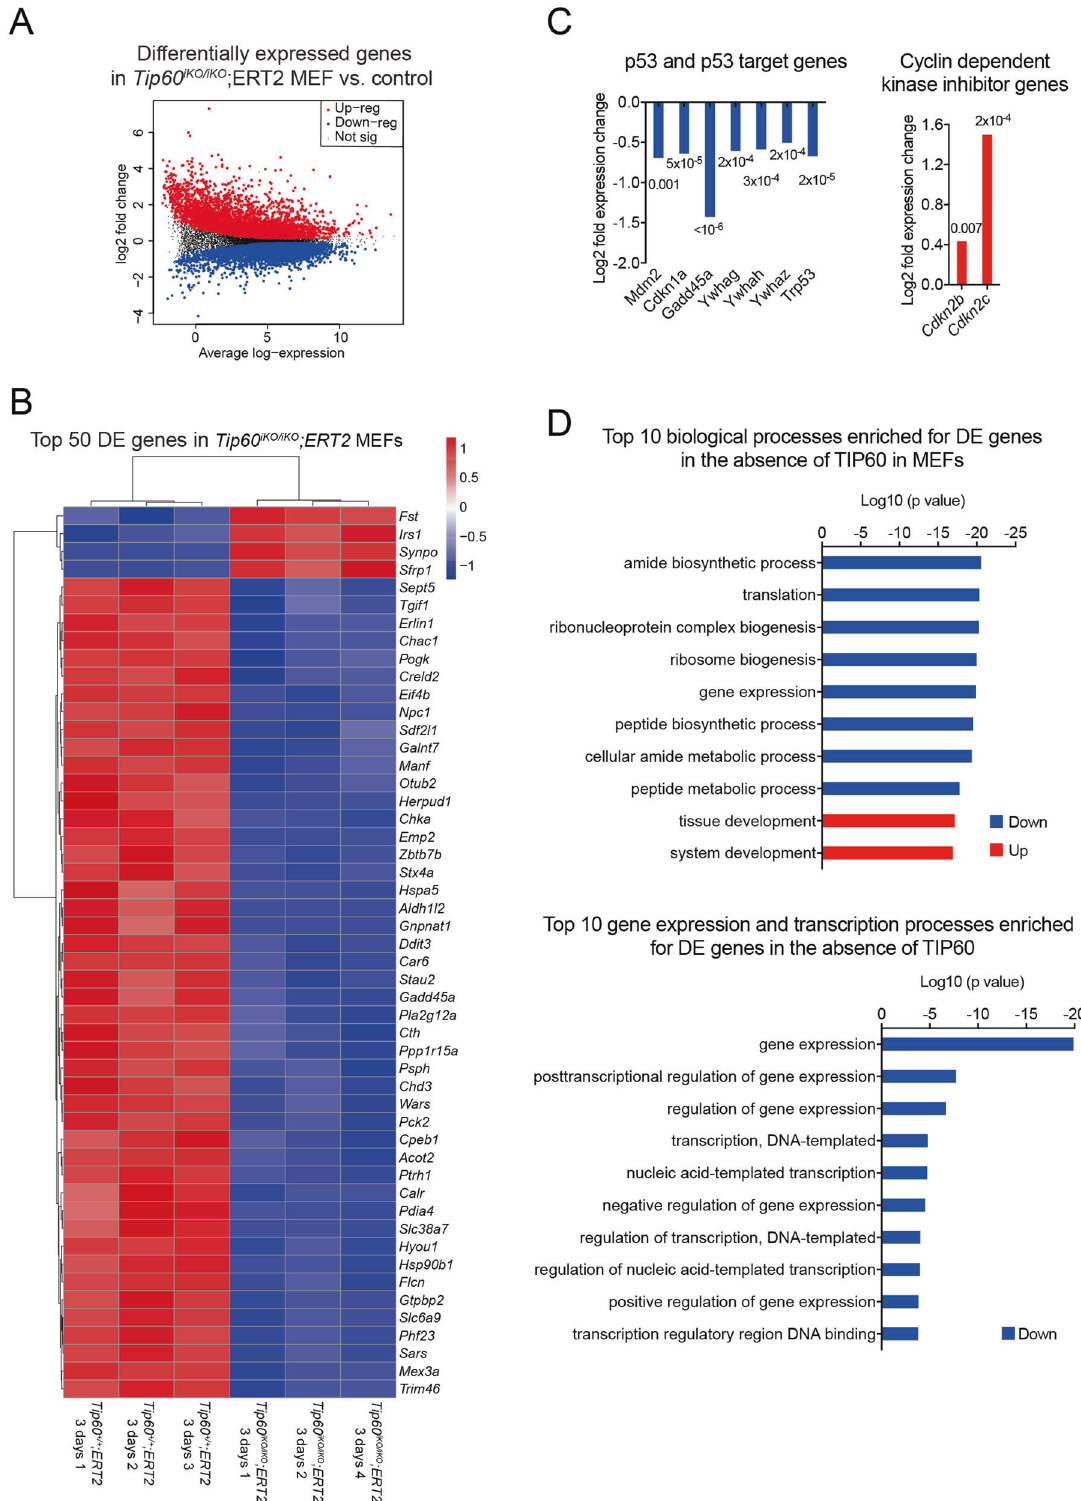
experience critically low levels of TIP60 and de fi ciencies in gene expression. Thus, only a small proportion of cells undergo endoreplication due to the lack of TIP60, while the majority undergo cell cycle arrest without endoreplication. The same effect might be the reason for our observation that not all cells display